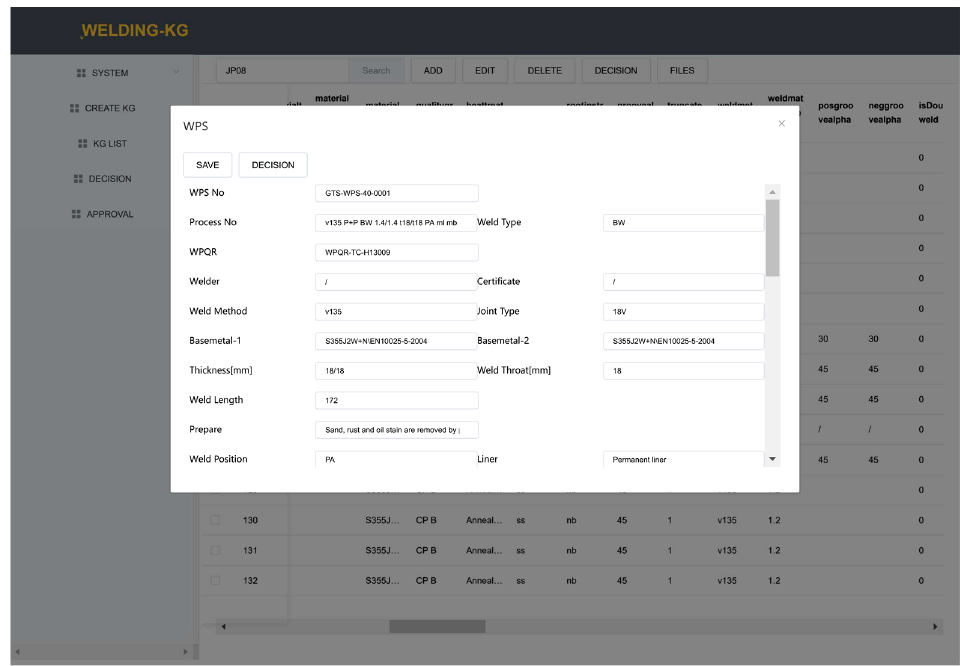
Figure 6. Structured document decision and view.